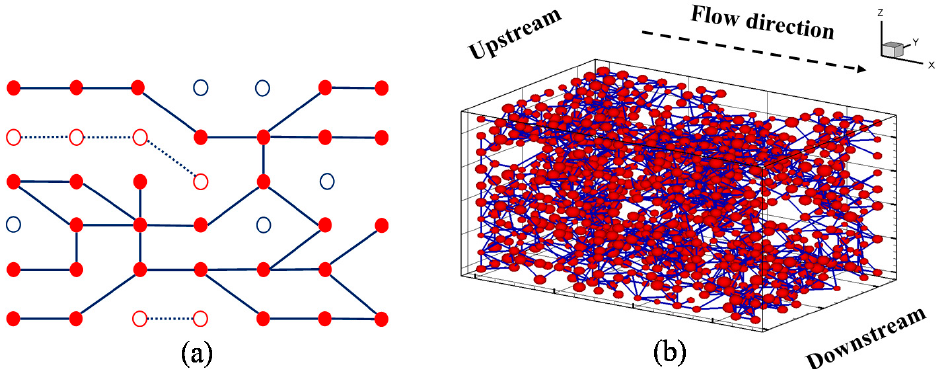
Figure 3. Regular shale matrix pore network model: ( a ) sketch map of diluted pore network; and ( b ) extracted backbone of three-dimensional pore network.